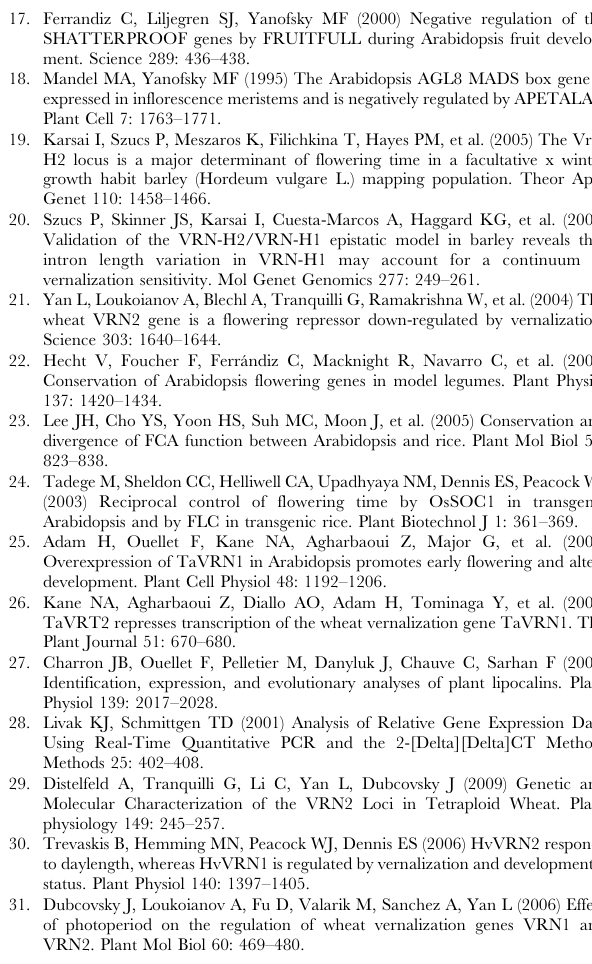
Table S1 List of primers used in this study. PDF)